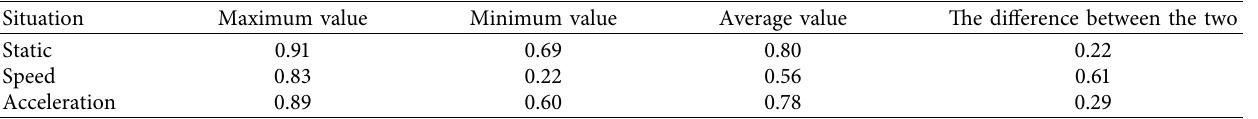
Table 3: Comparsion of three